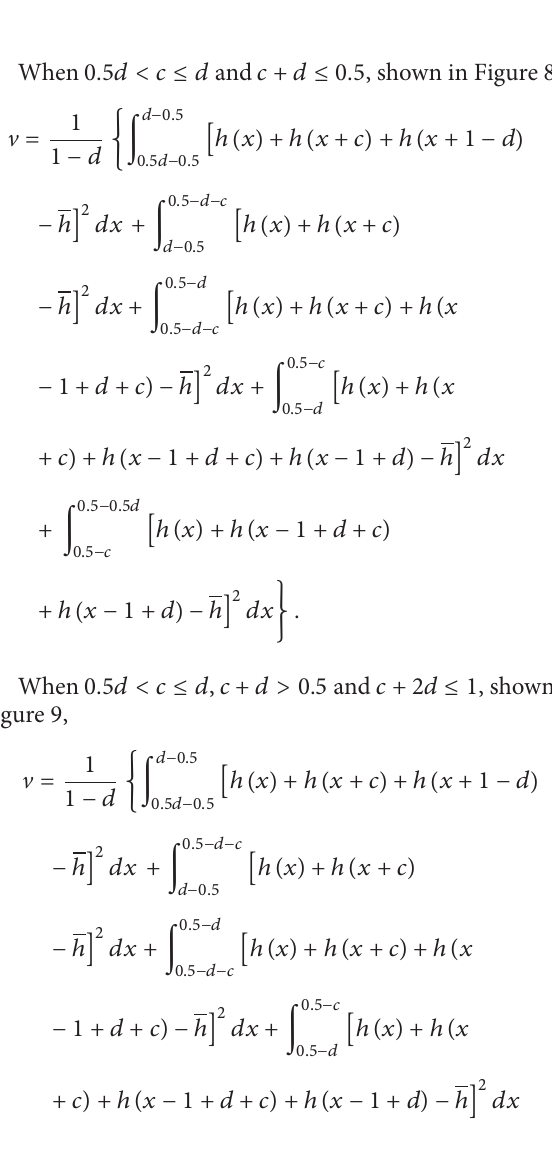
Figure 8: Coating thickness distribution when 0.5𝑑 < 𝑐 ≤ 𝑑 and 𝑐 + 𝑑 ≤ 0.5 .